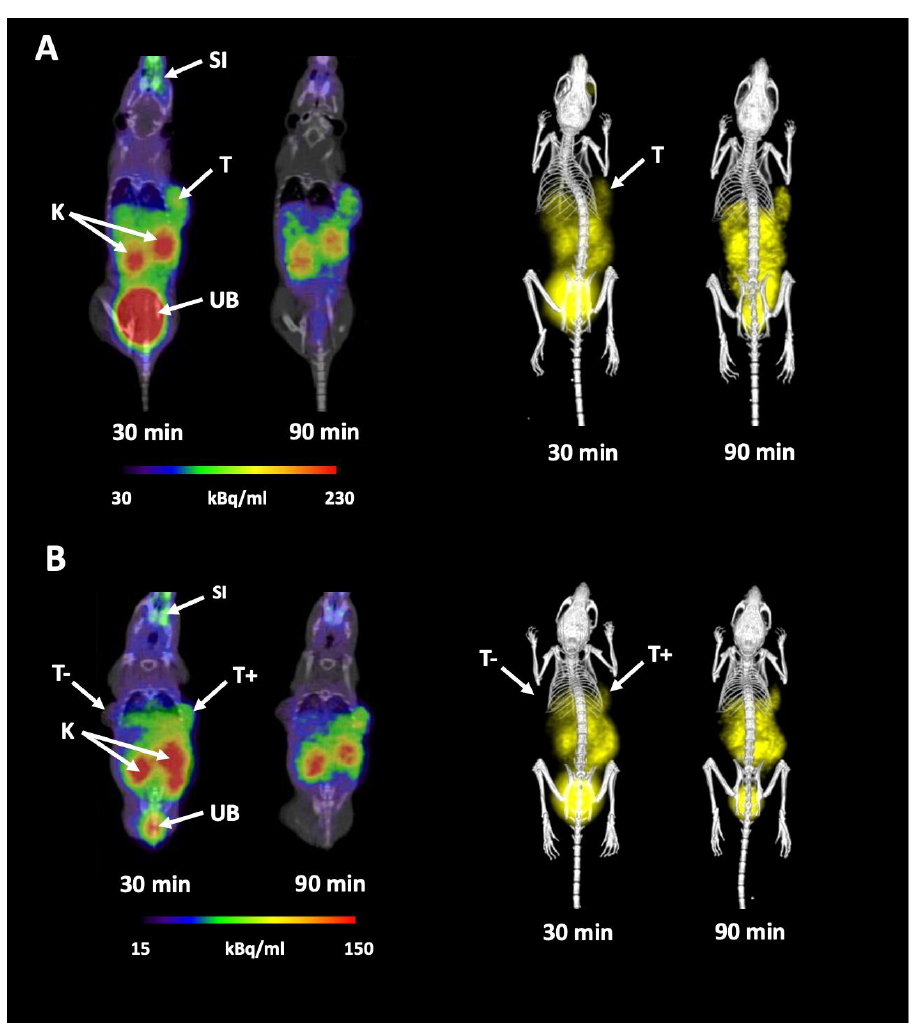
Figure 5. Static PET/CT imaging (coronal slices and 3D volume rendered images) of [ 68 Ga]Ga-DFO- c(RGDyK) in tumor-bearing (U-87 MG ( A ) or M21 and M21-L ( B )) Balb/c nude mice 30 and 90 min after r.o. injection; K = kidneys, SI = site of injection, T = U-87 MG tumor, T+ = M21 tumor, T− = M21- L tumor, UB = urinary bladder.